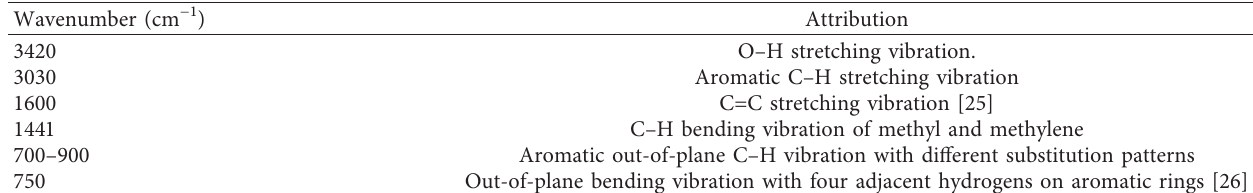
Figure 2: FT-IR spectra of raw materials and the cokes of MM-8-1 heat-treated at different temperatures. Table 1: The attribution of the peaks in the FT-IR